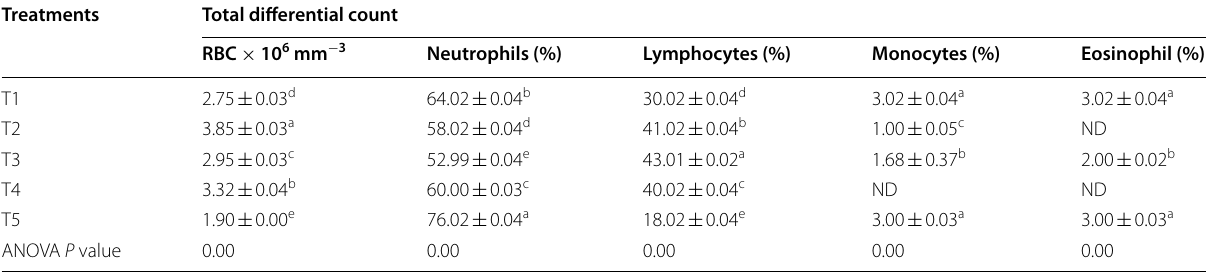
Figures in each column having the same superscripts are not significantly different at P > 0.05 Mean in a given row with the same letter a, b, c, d or e were not significantly different at ( P >